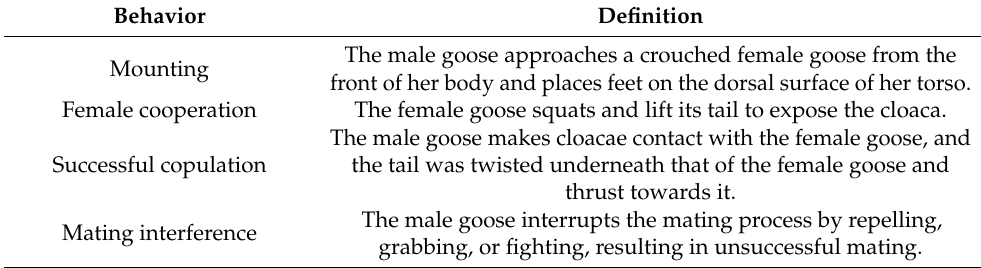
Table 2. Description of criteria for the mating